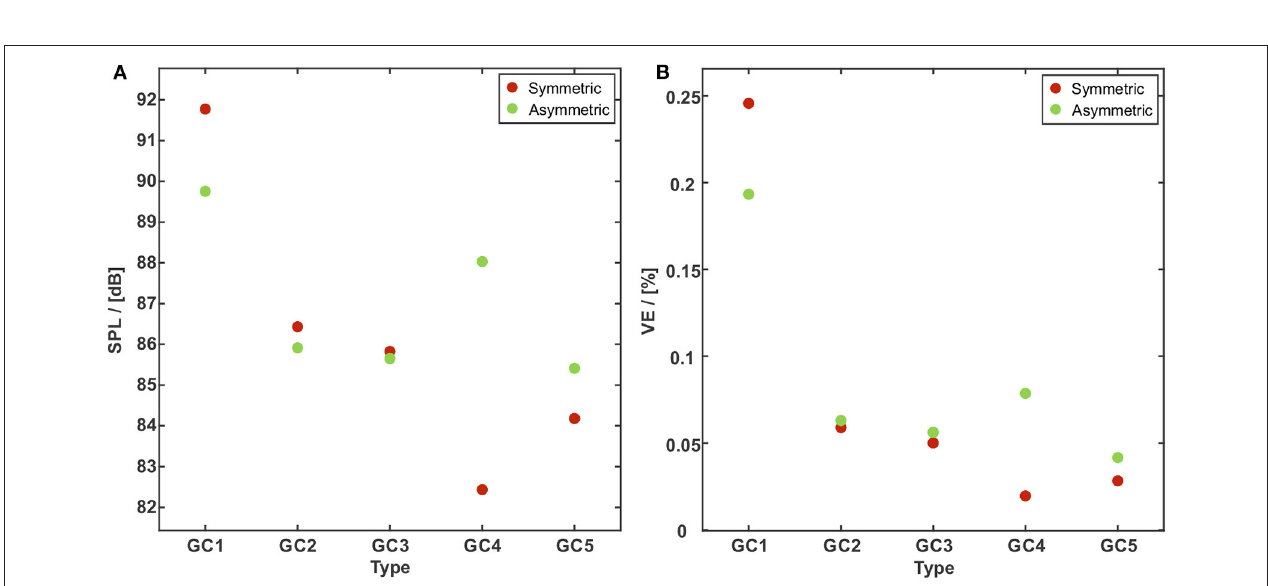
FIGURE 11 | SPL (A) and VE (B) vs. the GC types with a symmetric (red dots) and an asymmetric (green dots) vocal fold motion. The SPL and the VE significantly decrease with an increasing glottal insufficiency. The comparison between both motion types shows significant differences for GC1 and GC4 and only minor differences for GC2, GC3,